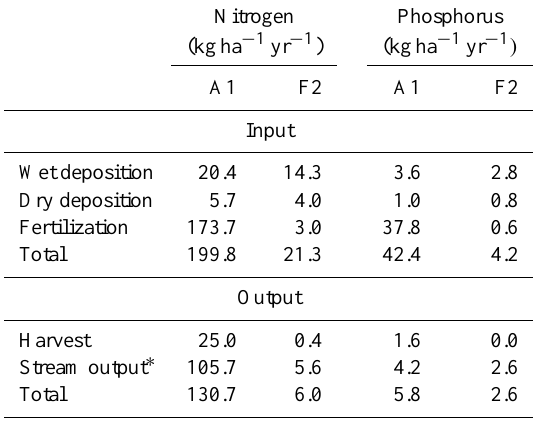
Table 4. Inputs and outputs of nitrogen and phosphorus of water- sheds A1 and F2. See text for the assumptions made in the calcula- tions of dry deposition, fertilization, and